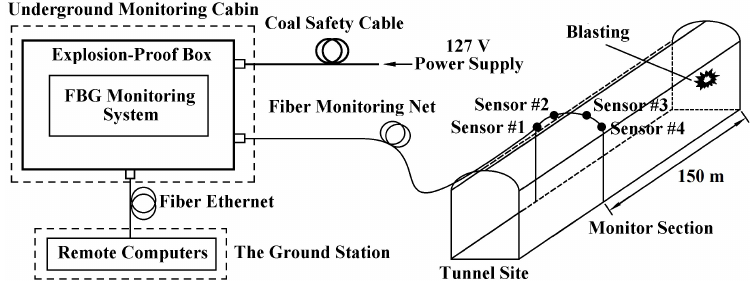
Figure 8. Underground fiber Bragg grating remote monitoring system.